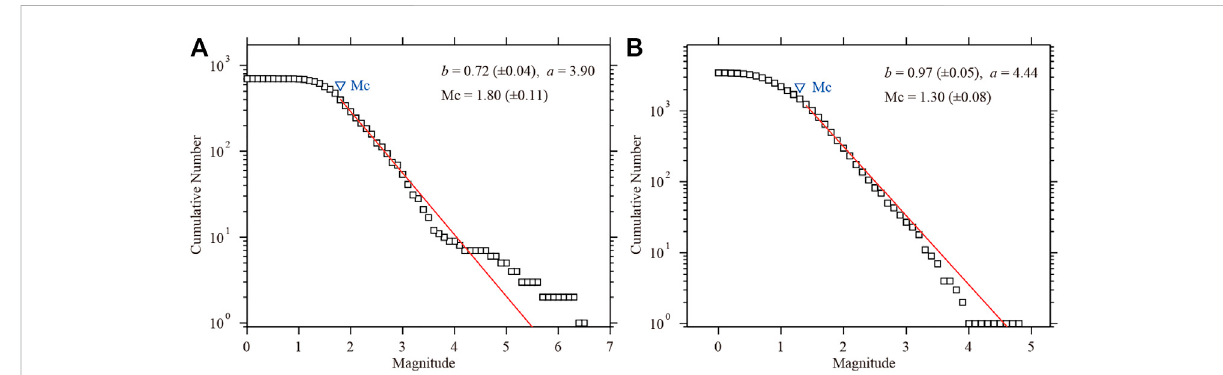
FIGURE 6 Frequency – magnitude distributions (A) before and (B) after the deployment of three portable stations.